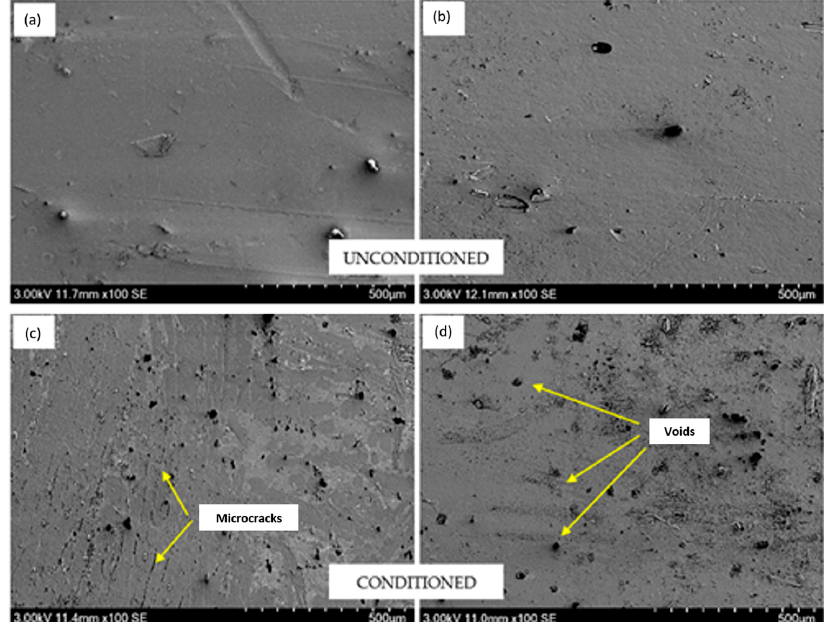
Figure 11. SEM micrographs of unconditioned nanosilica modified ( a ) BFRP and ( b ) GFRP and conditioned nanosilica modified ( c ) BFRP and ( d ) GFRP composites